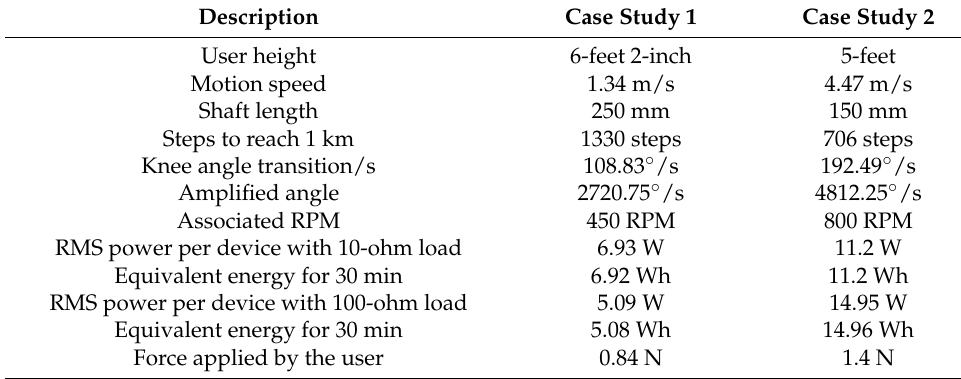
Table 5. Summary of case